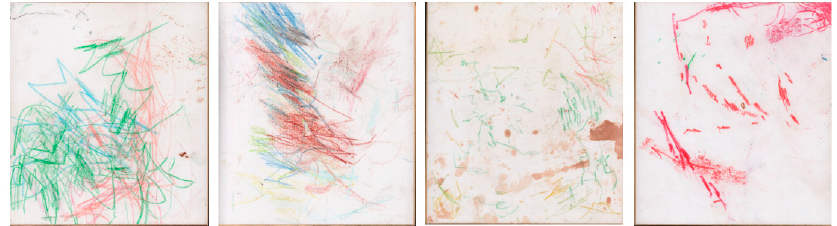
Figure 1. Examples of Molly’s drawings. The season of each drawing, from the left to the right, is autumn, spring, summer, and winter. Credits goes to the Tama Zoological Park.